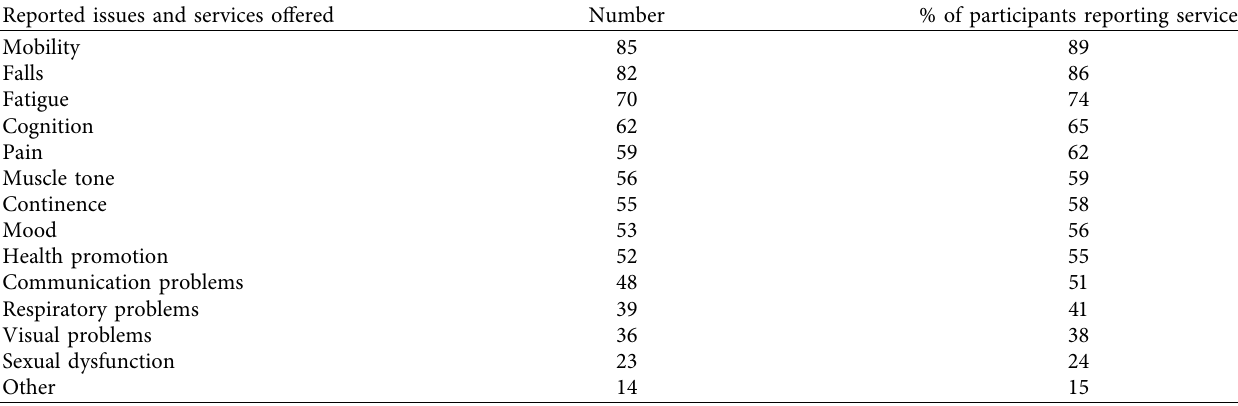
Table 3: Issues HCPs reported offering support and services for people with MS with.